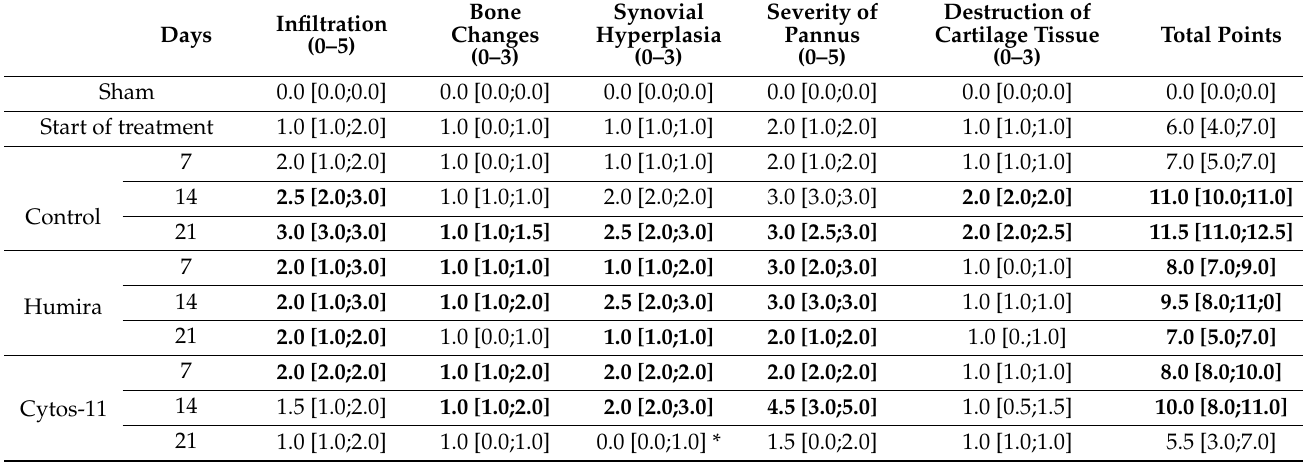
Table 1. Evaluation of the degree of destruction of joint elements in rats in the experiment (Median